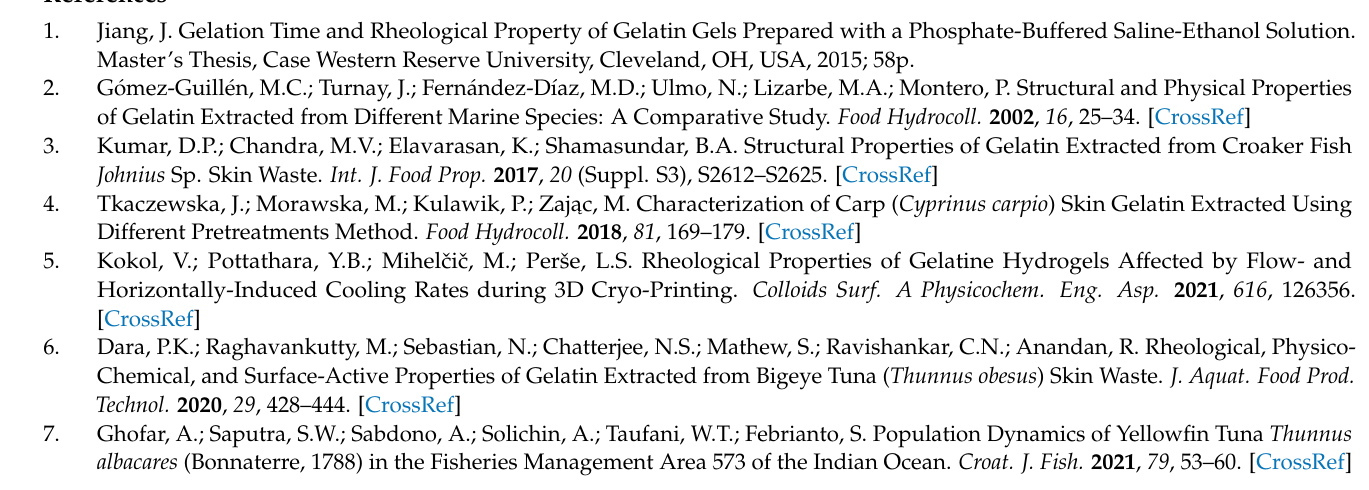
(b) Comparison of FTIR spectra at room temperature (dashes lines) and FTIR spectra at 50 ◦ C (solid lines) in the 2900–4000 cm − 1 region, of (-) Dry GE, (-) 25GE, (-) 25GE/DOX and (-) 25GE/Crocin; Figure S2: (a) DSC thermogram of Dry GE at 5 ◦ C · min − 1 (orange color) and at 1 ◦ C · min − 1 (green color), (b) DSC thermogram of 25GE at 1 ◦ C · min − 1 ; Figure S3: MDSC of (a) Dry GE in the Rev Heat Flow (green colour), Non Rev. Heat Flow (Black colour) and Heat Flow (red colour), (b) Dry GE at 1 K/min (Two reps), (c) 25GE in the Rev Heat Flow (green colour), Non Rev. Heat Flow (Black colour) and Heat Flow (red colour), (d) MDSC of 25GE in the Reversing Heat Flow; Table S1: The compilation of the major band assignments for Dry GE, 25GE, 25GE/Dox, and 25GE/Crocin at 25 ◦ C; Table S2. Major band assignments for Dry GE, 25GE, 25GE/Dox, and 25GE/Crocin at 50 ◦